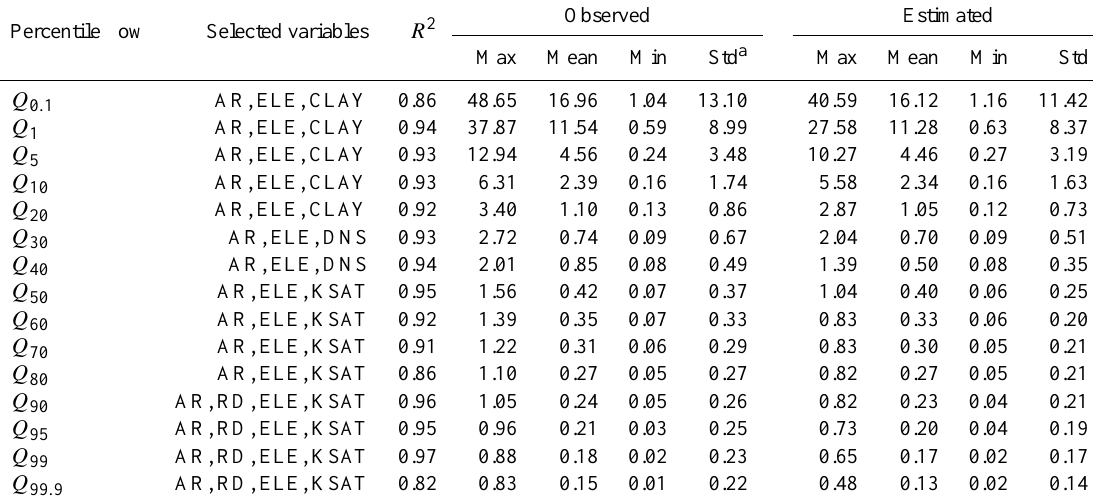
Table 5. Selected variables and statistics of the regional FDC method. Percentile